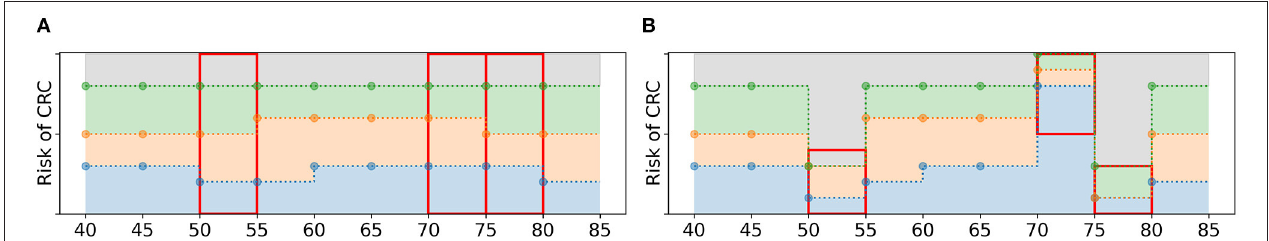
FIGURE 6 | Schematic overview of the mutation of a policy. (A) A policy before mutation. If p e = 3 / 9, the algorithm is likely to select three age groups, marked by the three red boxes. (B) For each age group, new policy bounds are sampled from a subset of R (red boxes). For age groups 50 and 75, ˜ r is 0.4 and 0.3, resp., and it is an upper bound. Therefore, the new values of the policy bounds must be smaller or equal to 0.4 and 0.3, resp. For age group 70, ˜ r = 0.5 is a lower bound and all new values are larger or equal to 0.5.